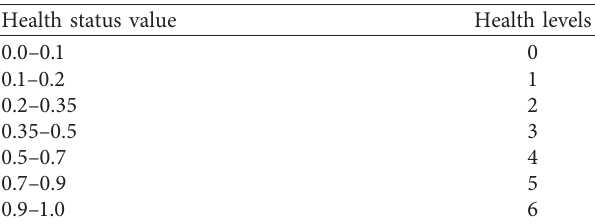
Table 2: Health classification of transmission